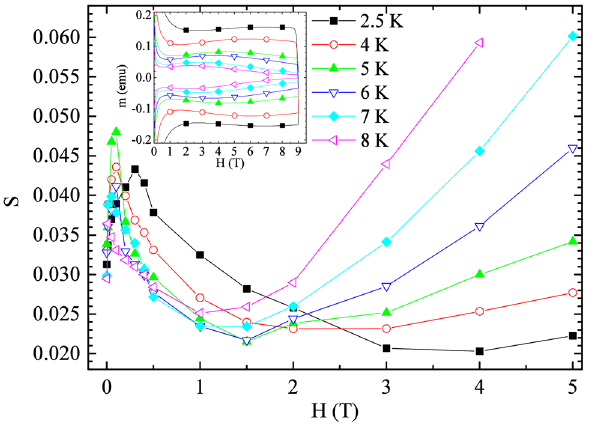
Figure 1. Field dependence of the normalized relaxation rate S. The solid lines are only a guide for the eyes. Inset: The SMP phenomenon in the superconducting hysteresis loops is